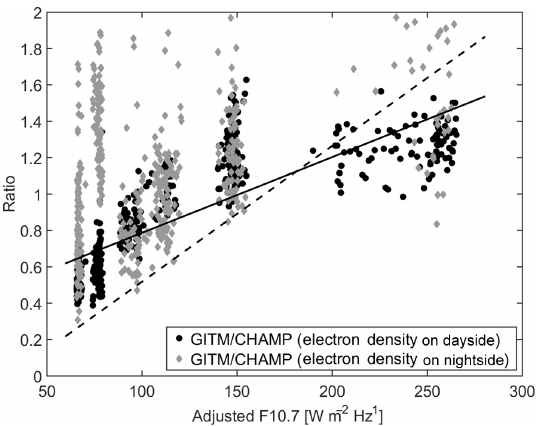
Figure 23. Effect of the solar activity on a large dataset of GITM simulations in comparison with CHAMP electron number density. The solid line represents the linear interpolation of all neutral den- sity ratios (from Fig. 22). The dashed line represents the linear in- terpolation of dayside-only electron number density ratios.